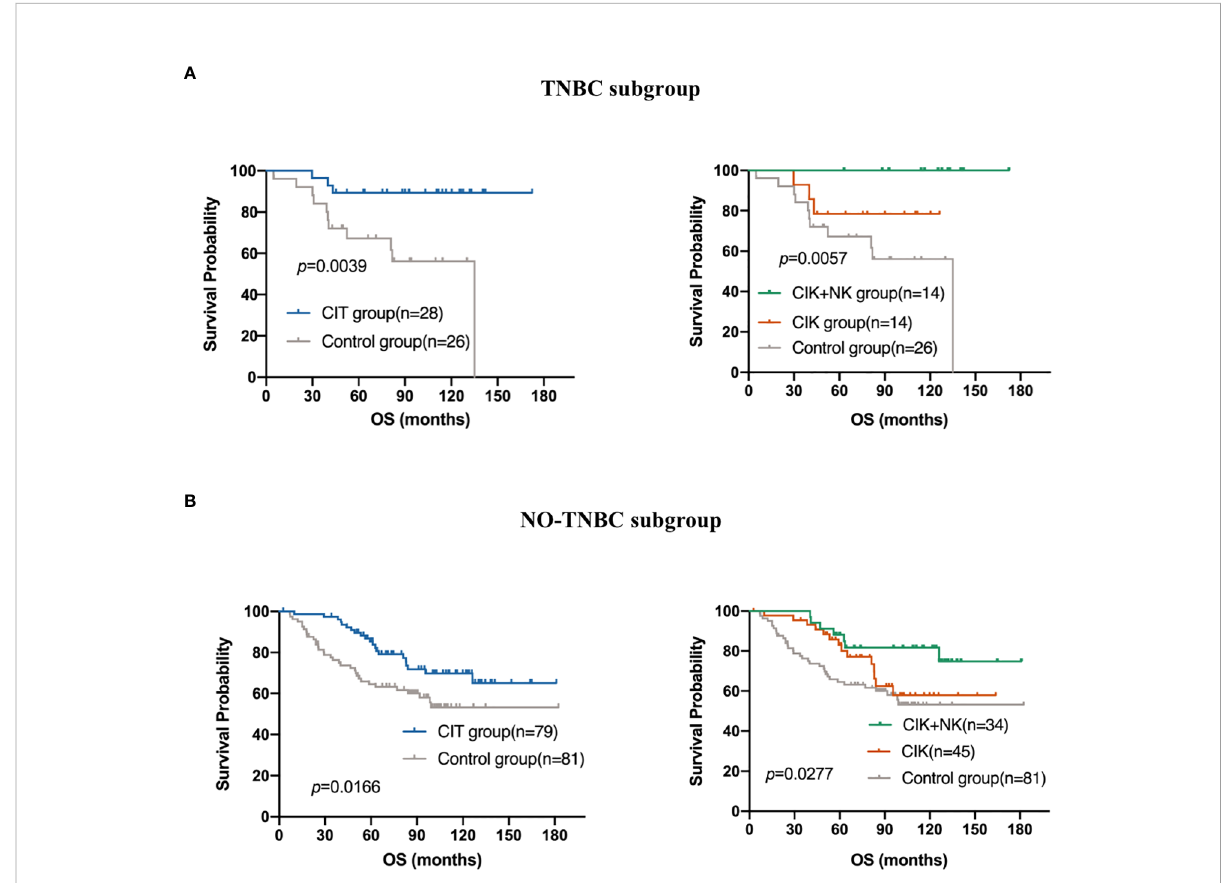
FIGURE 5 Subgroup analysis to estimate the survival bene fi ts from CIT in (A) Triple-negative breast cancer (TNBC)(n=54) and (B) NO-TNBC subgroup (n=160).